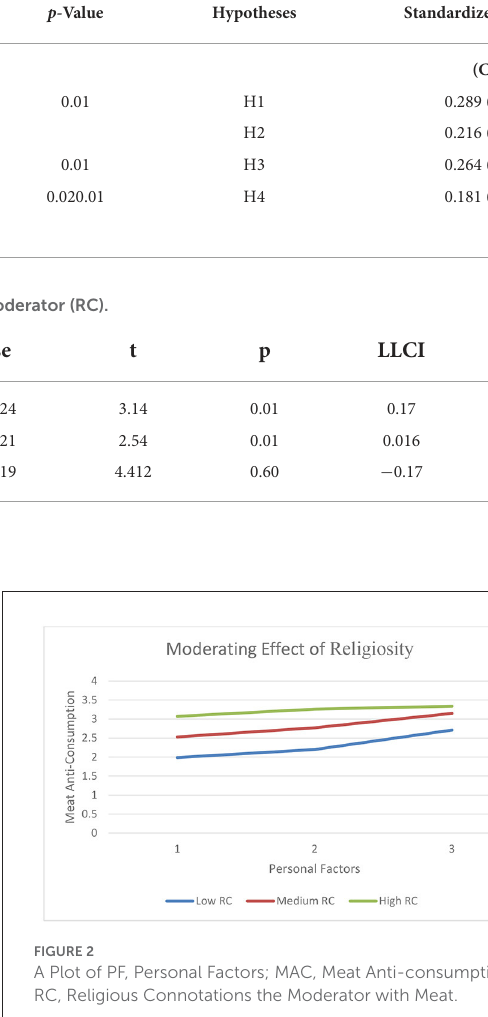
meat anti-consumption motives also decrease. The